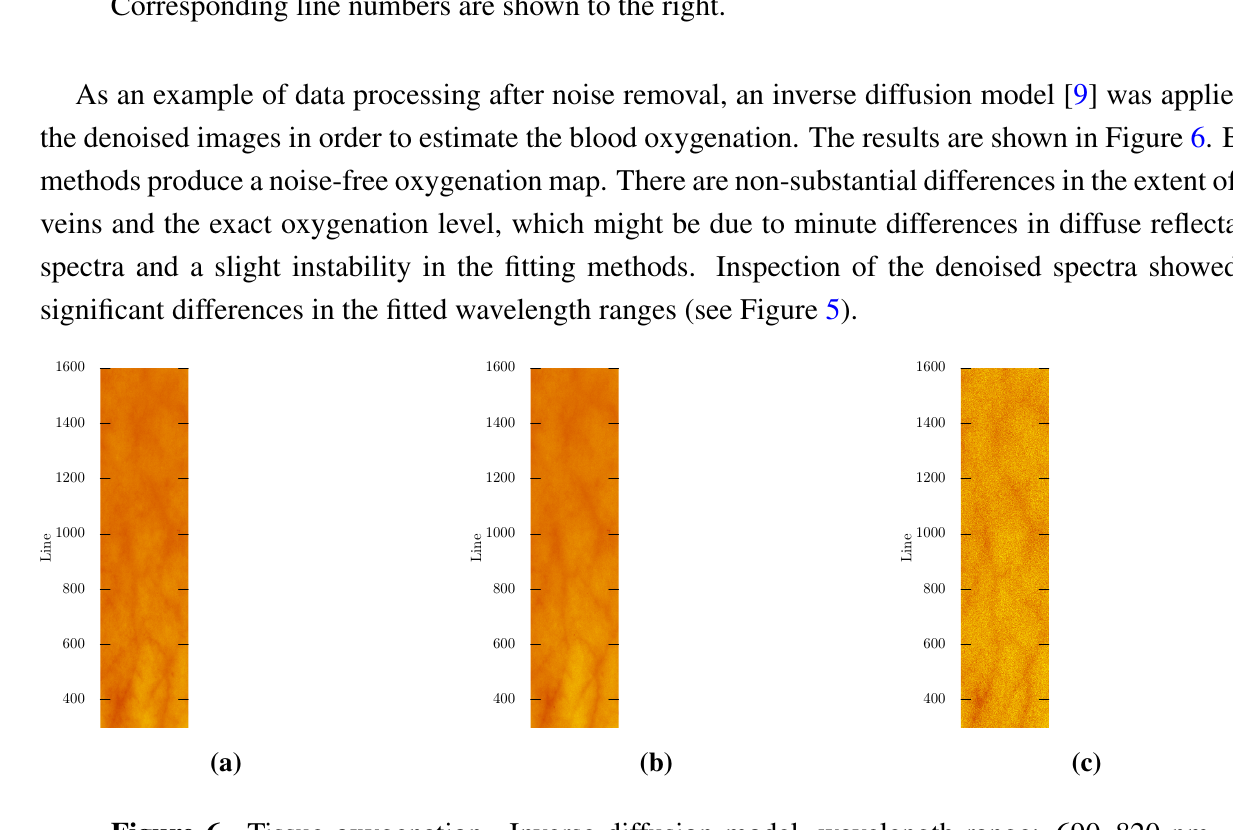
Figure 6. Tissue oxygenation. Inverse diffusion model, wavelength range: 690–820 nm (see [9] for details). ( a ) MNF-LBL; ( b ) MNF; ( c ) Noisy